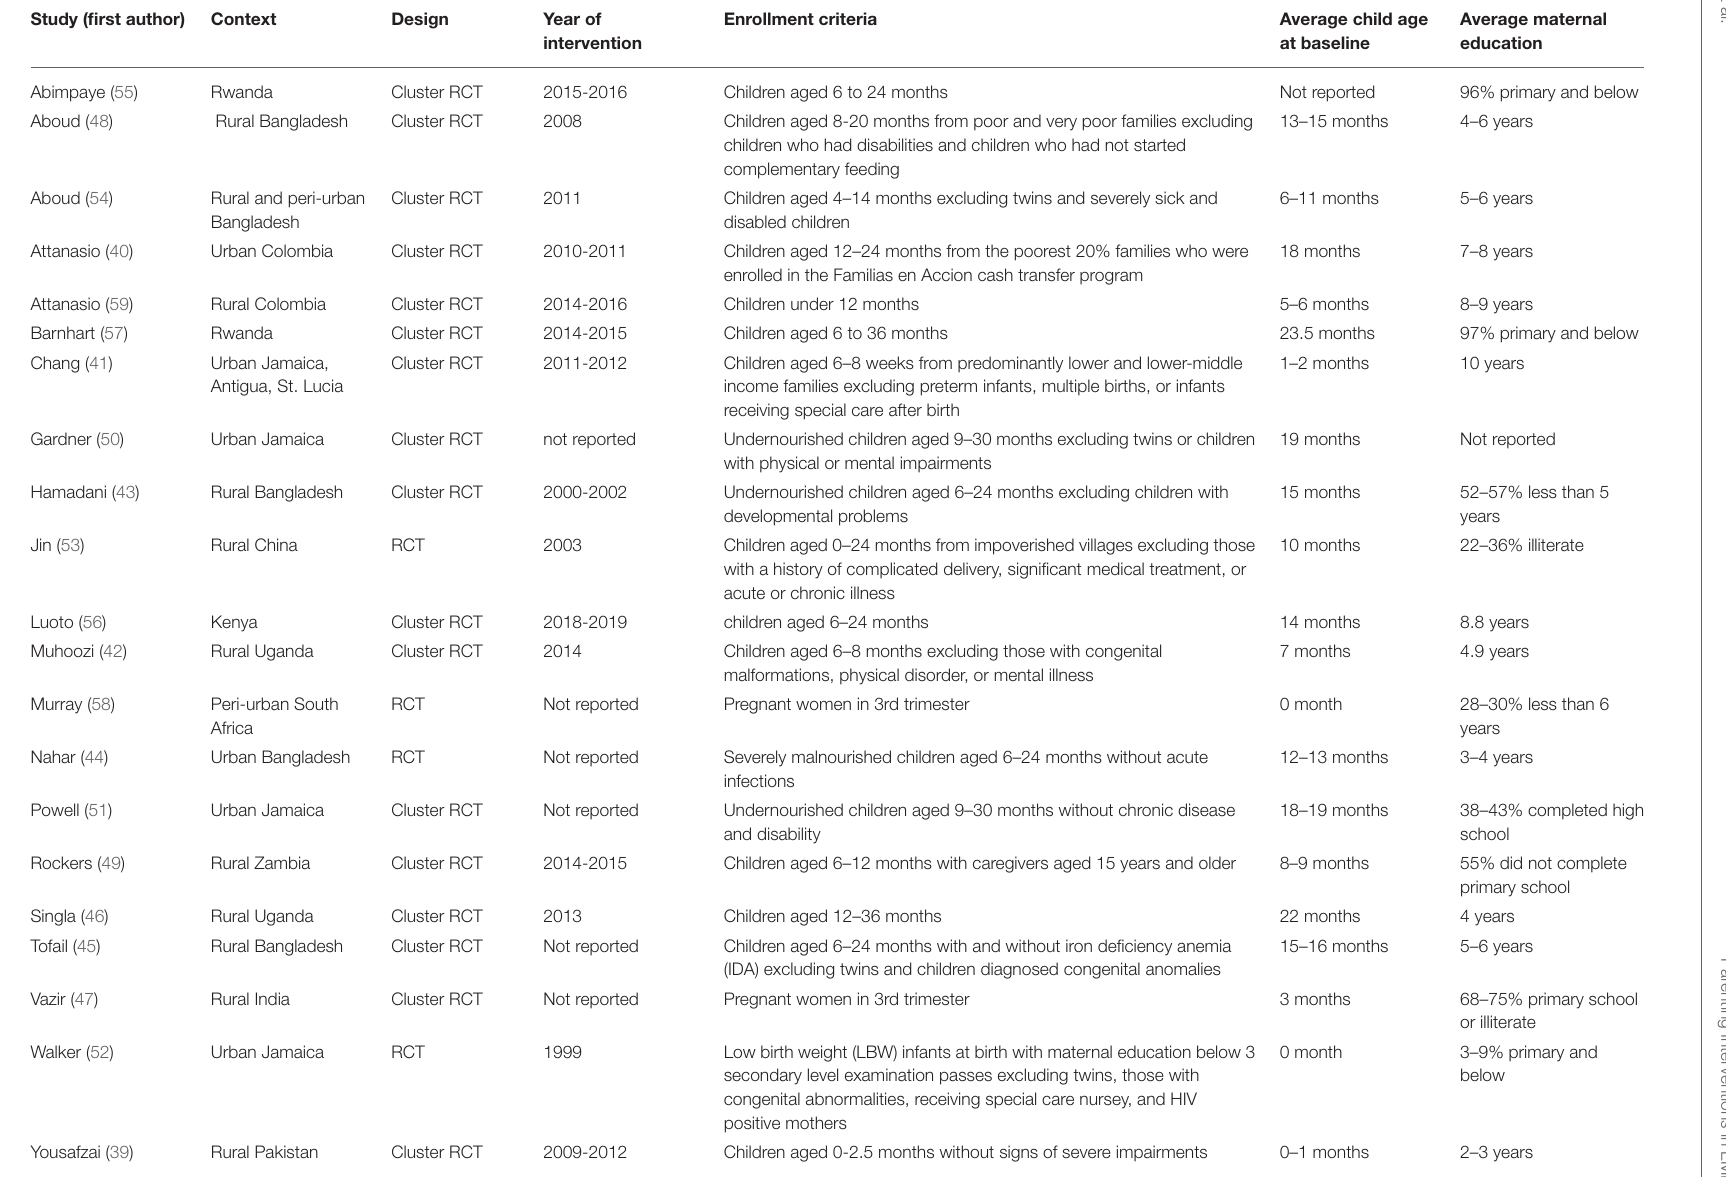
TABLE 1 | Study and sample